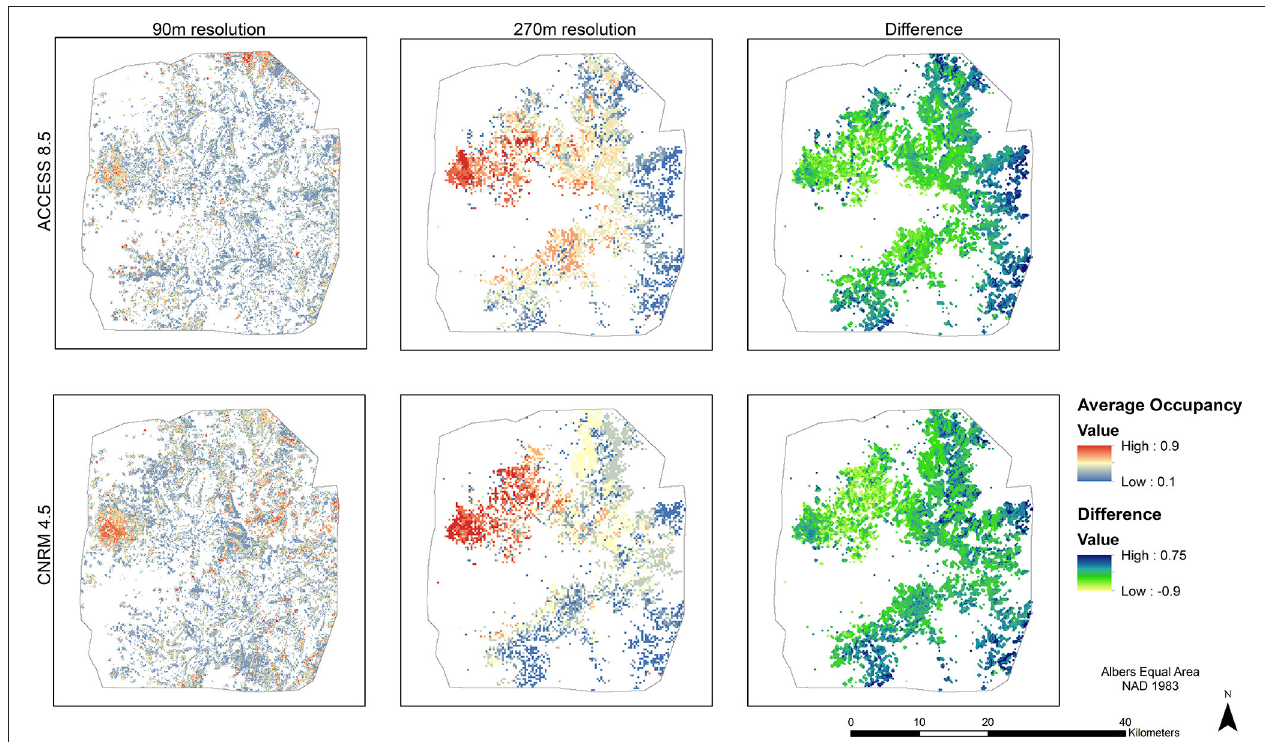
FIGURE 5 | (Left) Map of occupancy for the three species in year 2105 for the 90m model, averaged across seven replicates and scaled between 0 (no species present in cell) and 1 (all species present in cell). (Middle) Map of occupancy for the three species in year 2105 for the 270m model, averaged across nine replicates. (Right) Difference between the two (90m map minus the 270m